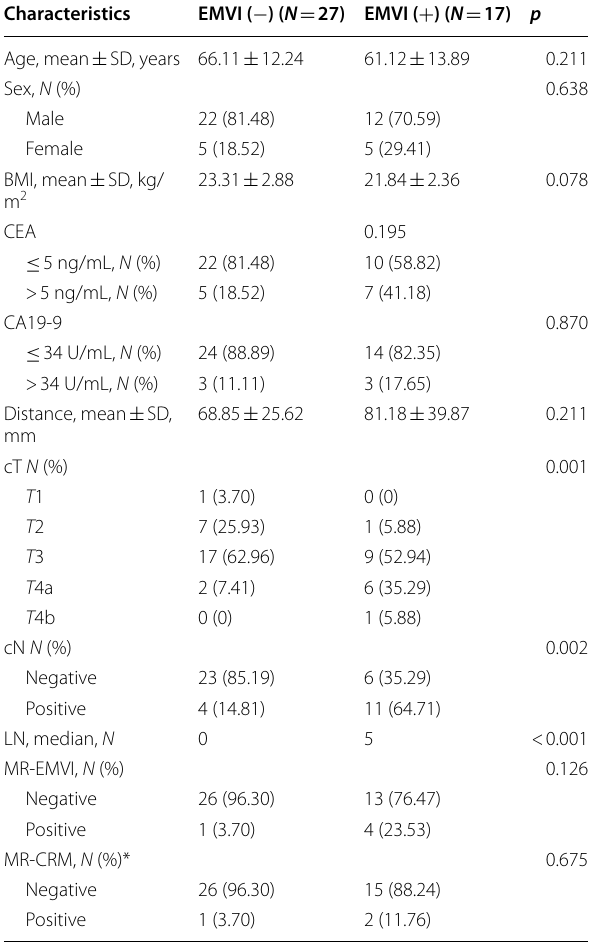
Table 1 Associations between EMVI and clinical risk predictors in train